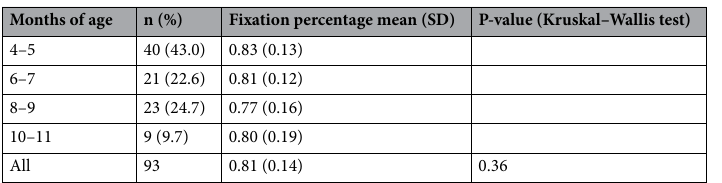
Table 2. Fixation time percentage of all sequence between four groups. n number of participants, SD standard deviation.